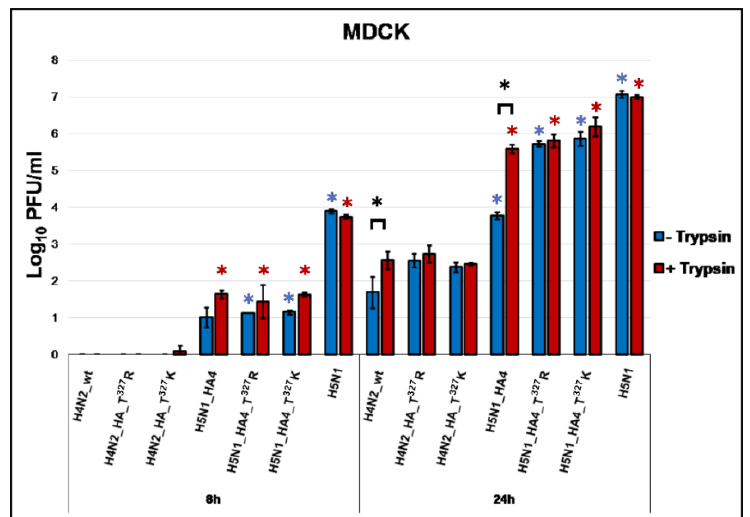
Figure 2. Replication kinetics of recombinant viruses in Madin – Darby canine kidney cells (MDCK) . Replication kinetics in MDCK cells at indicated time points after infection with H4N2 viruses with variable HACS or H5N1 gene segments with (T+) or without (T − ) trypsin. Titration was done in MDCKII cells and the results are shown as mean ± standard deviation Log 10 PFU/mL. Asterisks indicate significant di ff erence ( p < 0.05). Blue and red asterisks indicate significant di ff erences compared to H4N2_wt without or with trypsin, respectively. Black asterisks indicate significant di ff erences for replication of each virus in the presence or absence of